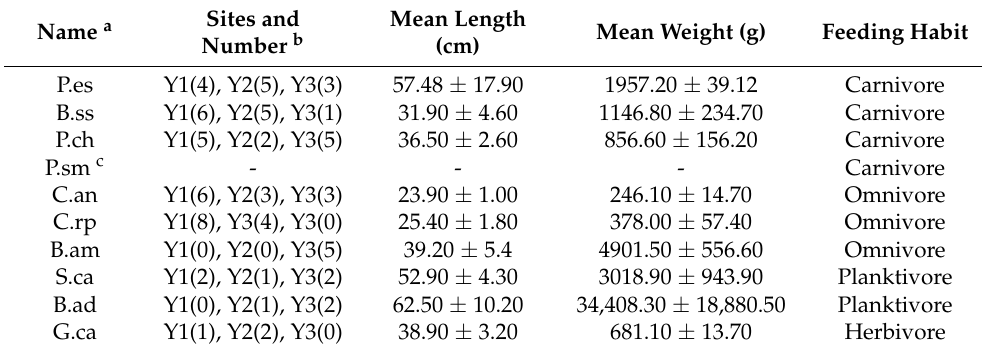
Table 1. Detailed information of the fish captured from Wulungu